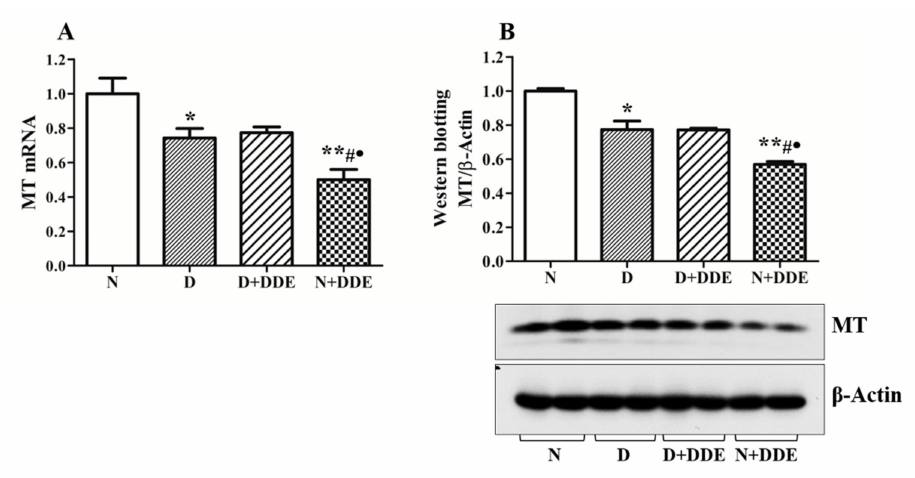
Figure 6. Analysis of metallothioneins (MT) gene expression ( A ) and MT protein levels ( B ) were graphically represented as fold change vs. N. The data were calculated as media ± standard